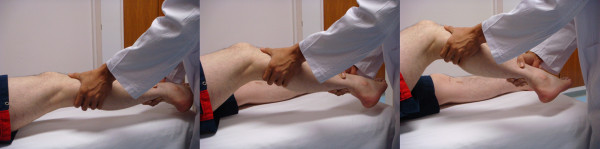
Pivot shift test.